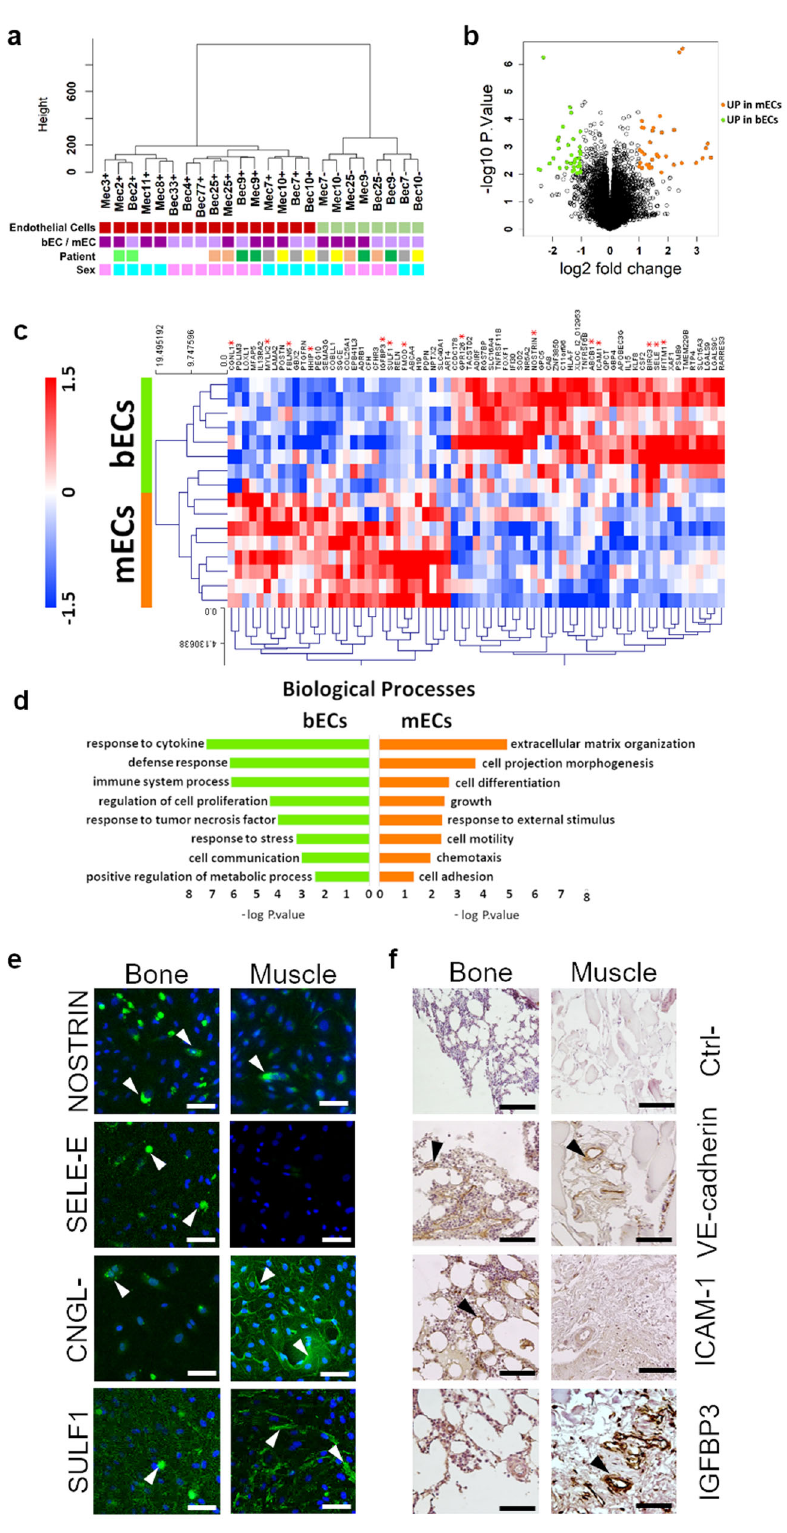
sprout, total sprout length and average branch length, altogether suggesting absence of correlation between angiogenic sprouting and systemic in fl ammation for bone derived ECs. On the contrary, an almost signi fi cant negative correlation was observed for the sprouting of mECs, (as shown in Fig. 3C: r 2 = 0.67, p = 0.08), suggesting a lower angiogenic potential in mECs derived from patients with higher systemic in fl ammation (Fig.